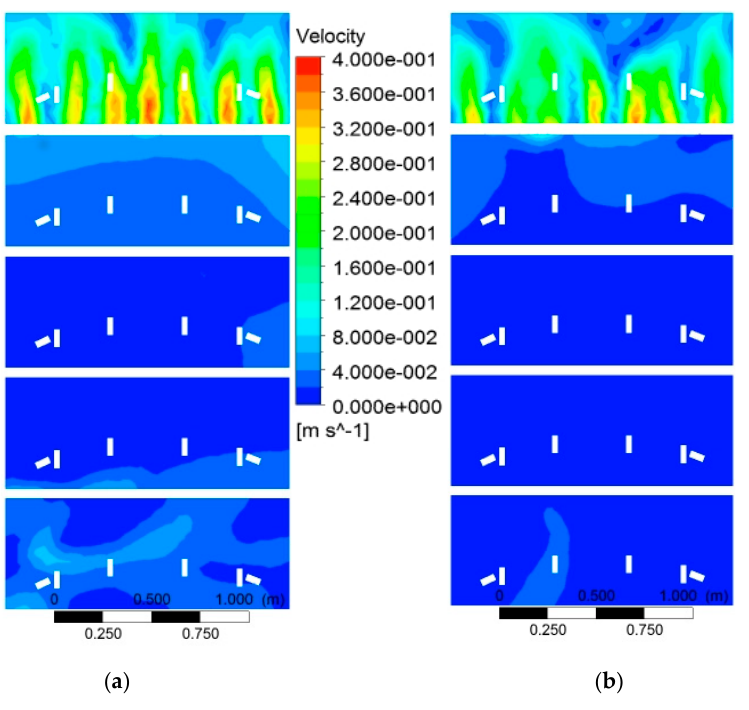
Figure 14. Computed velocity maps at frontal face areas of virtual boxes. ( a ) Original case and ( b ) Carousel with baffles installed through its perimeter to block the oil flow. Inlet oil velocity was 0.5